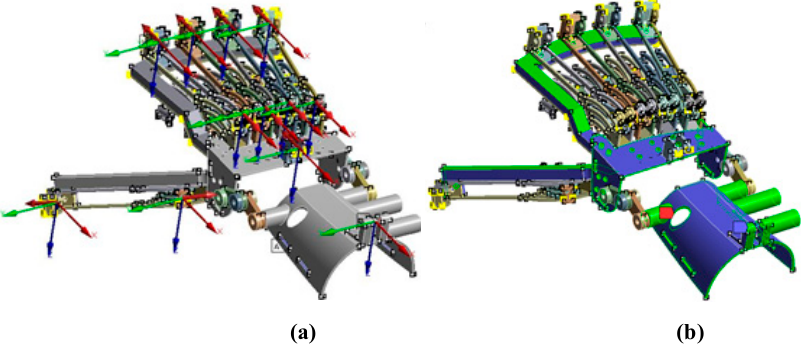
Figure 13. The boundary conditions ( a ) static analysis; ( b ) the optimized boundary conditions of topology.